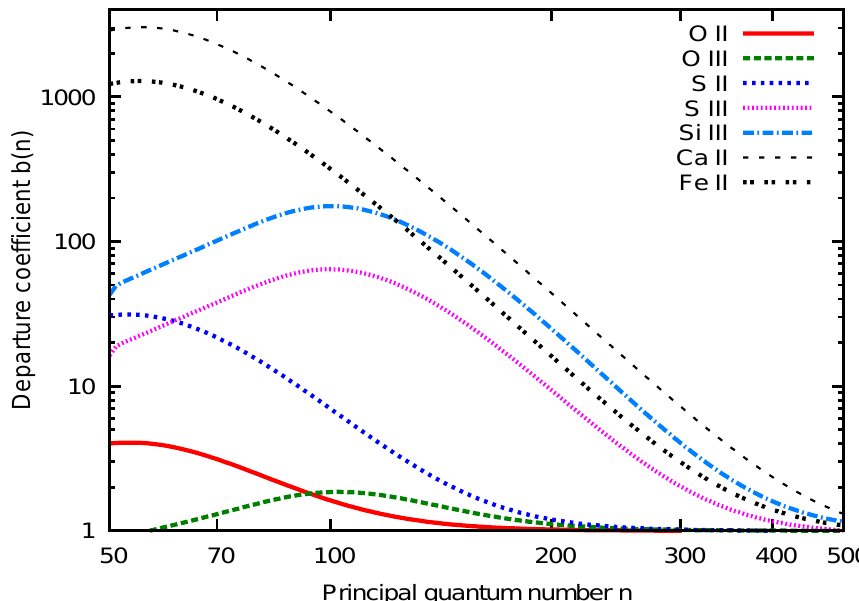
Fig. 1. Departure coefficients b n for abundant ions in the photoionization front.